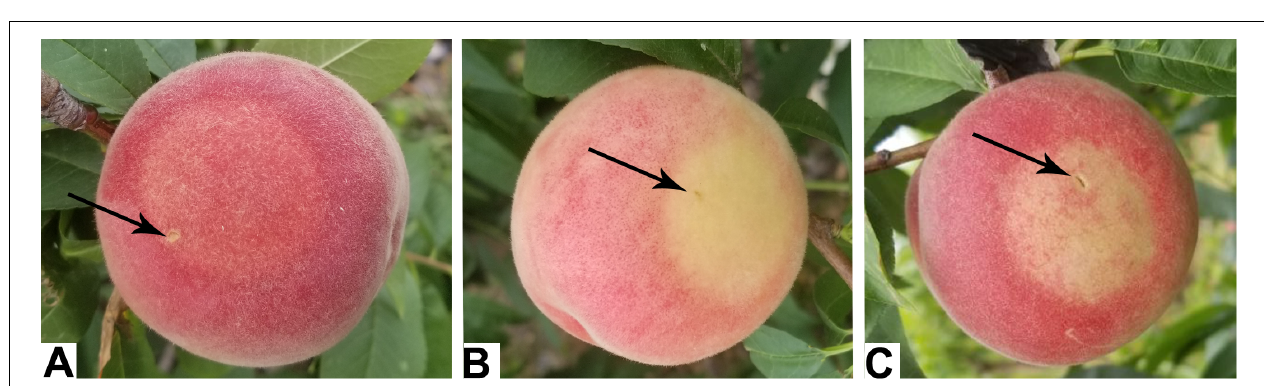
FIGURE 2 | Transcript levels of 17 PpBGALs in control, ethylene-treated, and 1-MCP-treated ‘Qian Jian Bai’ peach fruit during storage. The peach 18S rRNA gene was used as a reference. The experiment was repeated three times. Data represent the mean ± SE ( n = 3). Significant differences ( p < 0.05) between means are indicated by different